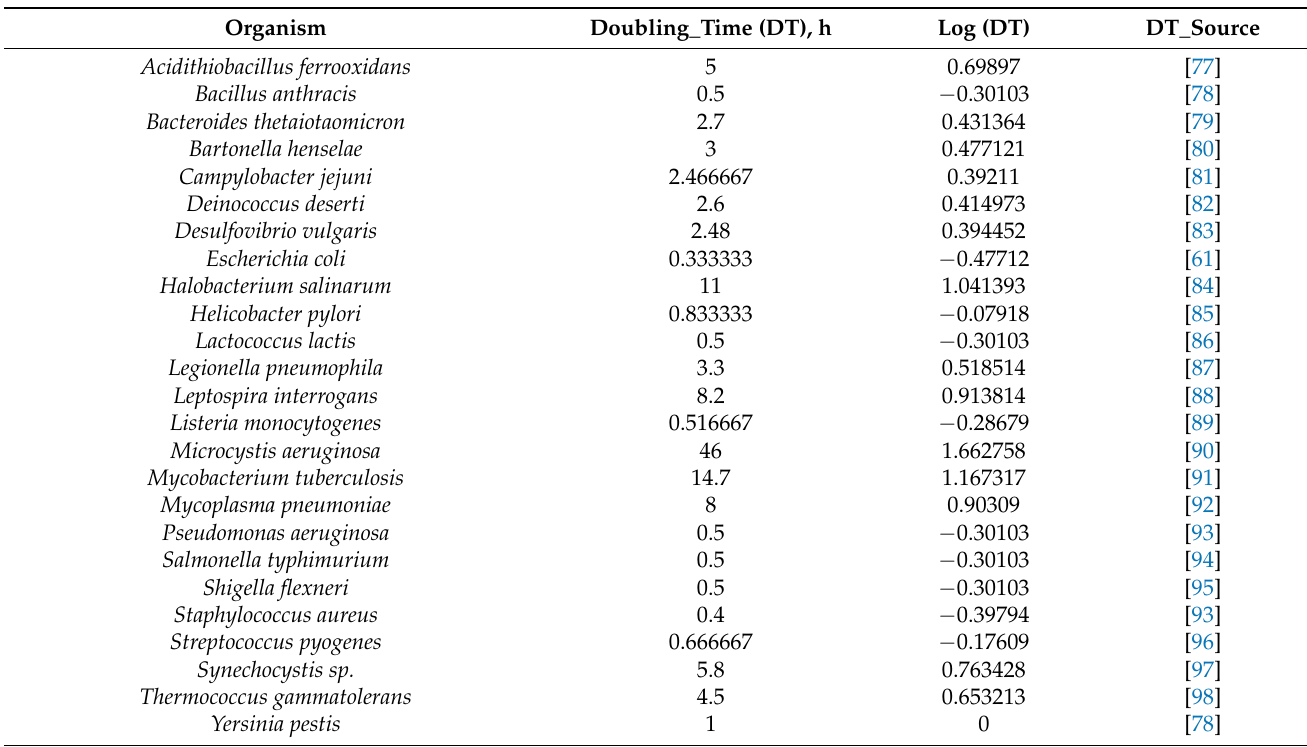
Table 4. The table reflects minimal doubling time for each species in hours and in a logarithmic form. The article from which the data were taken is also presented for each of the organisms (column